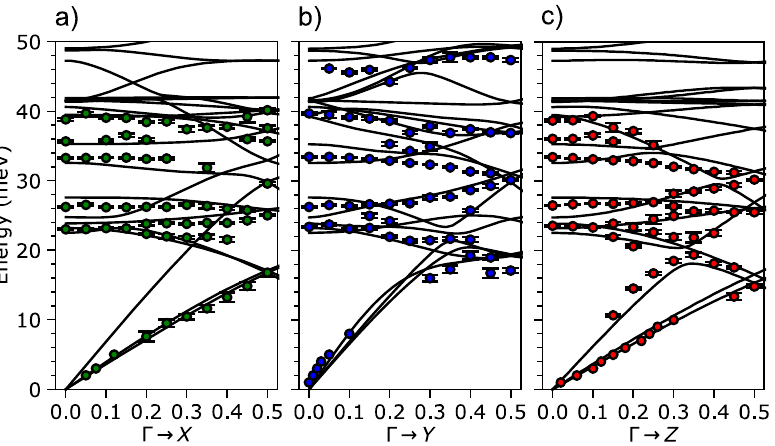
Figure 5. Phonon energies in FeP extracted from TOF data with the help of the Phonon Explorer software compared with DFT calculation results ( a ) Γ -X direction; ( b ) Γ -Y direction; ( c ) Γ -Z direction; (From Ref. [14]).